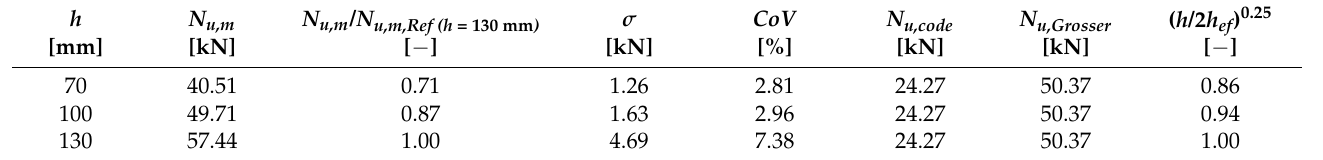
Table 8. Experimental results—in-field installation; 3 tests were performed for each configuration.